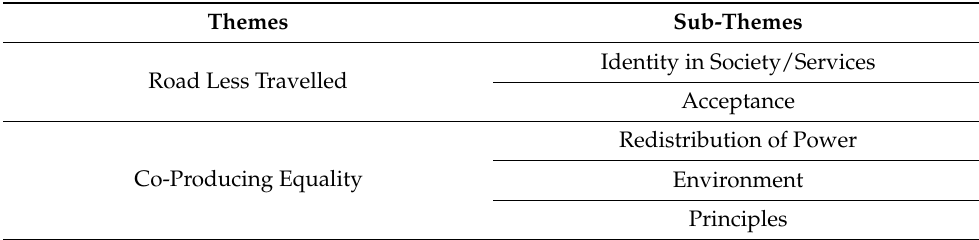
Table 6. Themes and